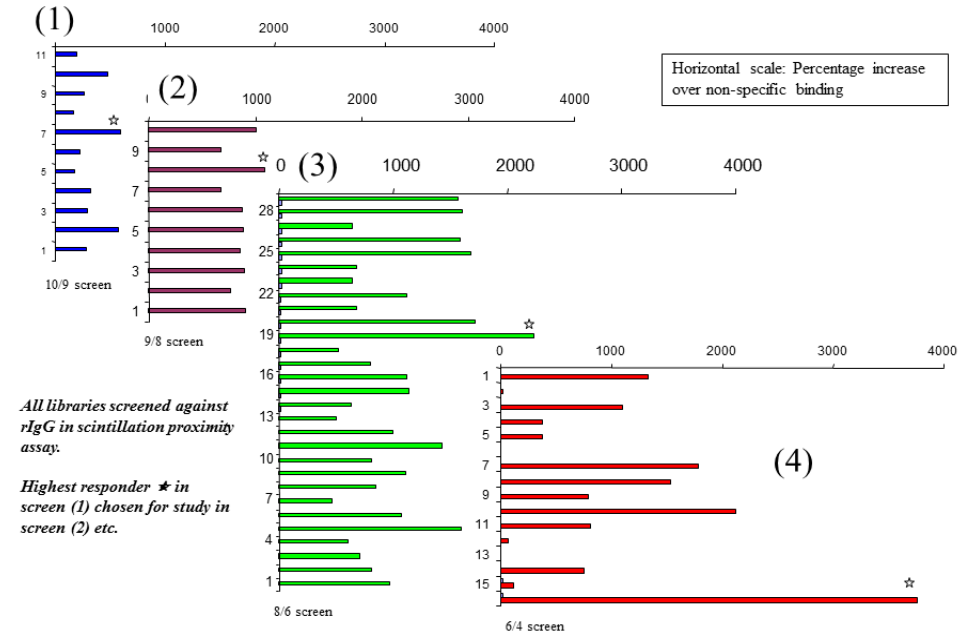
Figure 1. Iterative screens of Mozaic micelle libraries to identify an amino acid combination capable of binding strongly to IgG, using the scintillation proximity technique.